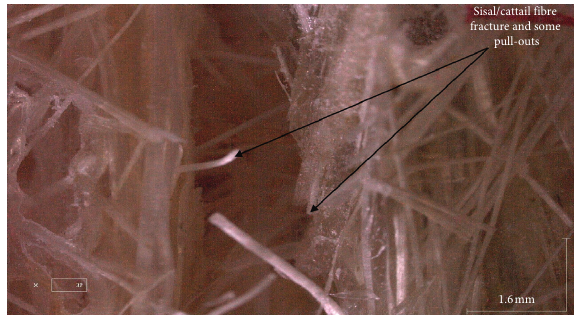
Figure 12: Hybrid composite at 20wt% hybrid fibre weight fraction and 75/25 sisal/cattail fibre content in the hybrid after tensile